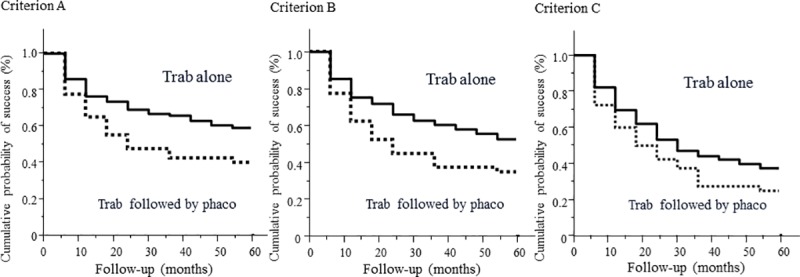
Kaplan–Meier survival curves of the 5-year probability of success in the trabeculectomy followed by phacoemulsification and trabeculectomy alone groups.(Left) For criterion A (intraocular pressure ≥ 21 mm Hg; <20% reduction of the preoperative intraocular pressure), (Center) for criterion B (intraocular pressure ≥ 18 mm Hg; <20% reduction of the preoperative intraocular pressure), and (Right) for criterion C (intraocular pressure ≥ 15 mm Hg; <20% reduction of the preoperative intraocular pressure). Surgical failure in all the criteria includes reoperation for glaucoma, loss of light perception, or low intraocular pressure (≤5 mm Hg). Trab = Trabeculectomy, Phaco = Phacoemulsification.